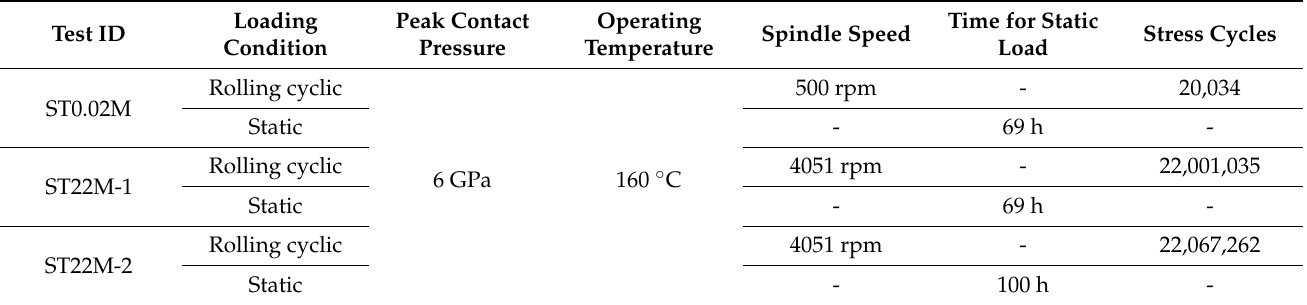
Table 2. Test conducted for static load